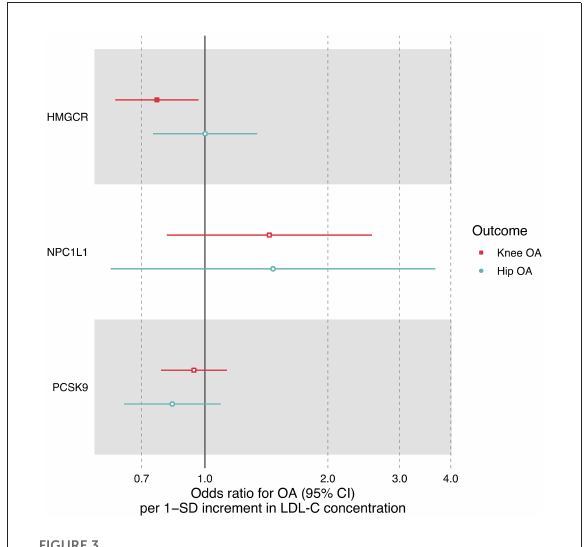
FIGURE3 Forest plot comparing causal effect estimates of LDL-C on OA risk restricted to three sets of SNPs within HMGCR, NPC1L1 and PCSK9 regions. Odds ratios (ORs) with 95% confidence intervals (CIs) are scaled to 1-SD increment in LDL-C